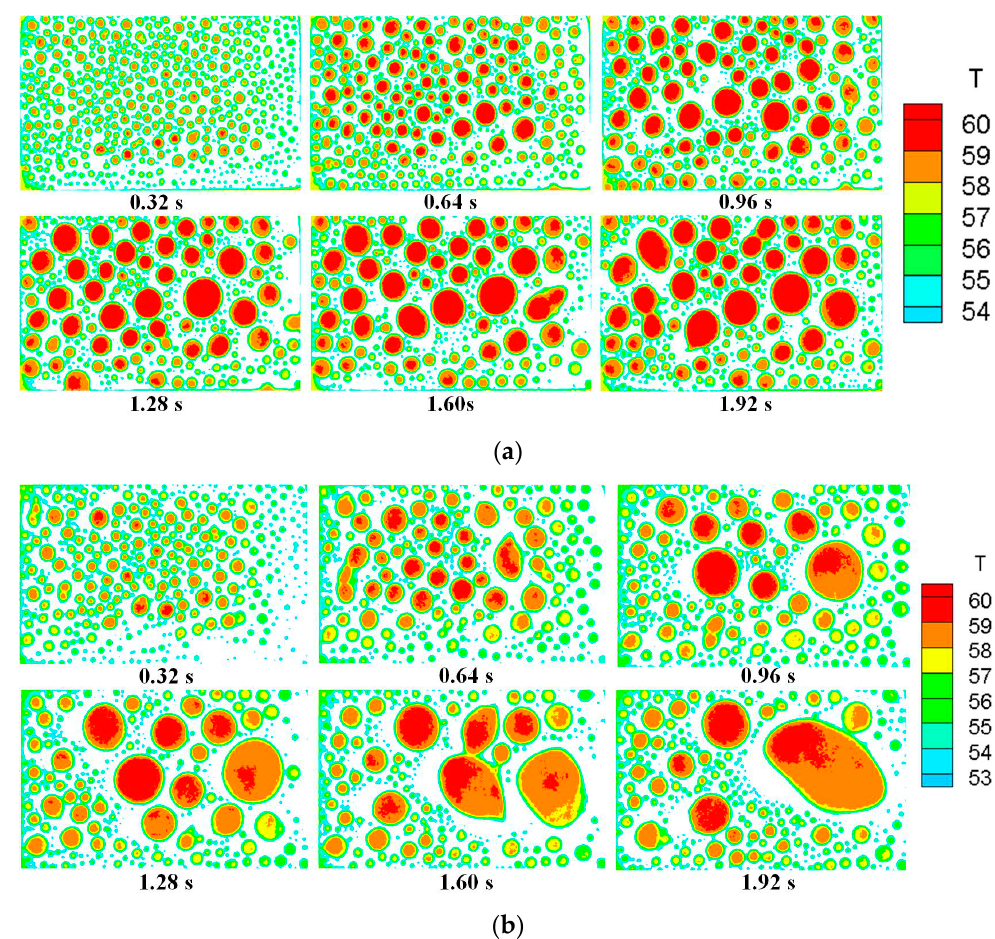
Figure 10. Top view of the temperature distribution of all the droplets on the condensing surface at different times with the experimental conditions of ( a ) P = 20 kPa, U = 3 m/s, W e = 1%, t c =55 °C; ( b ) P = 20 kPa, U = 3 m/s, W e =2%, t c = 50 °C.